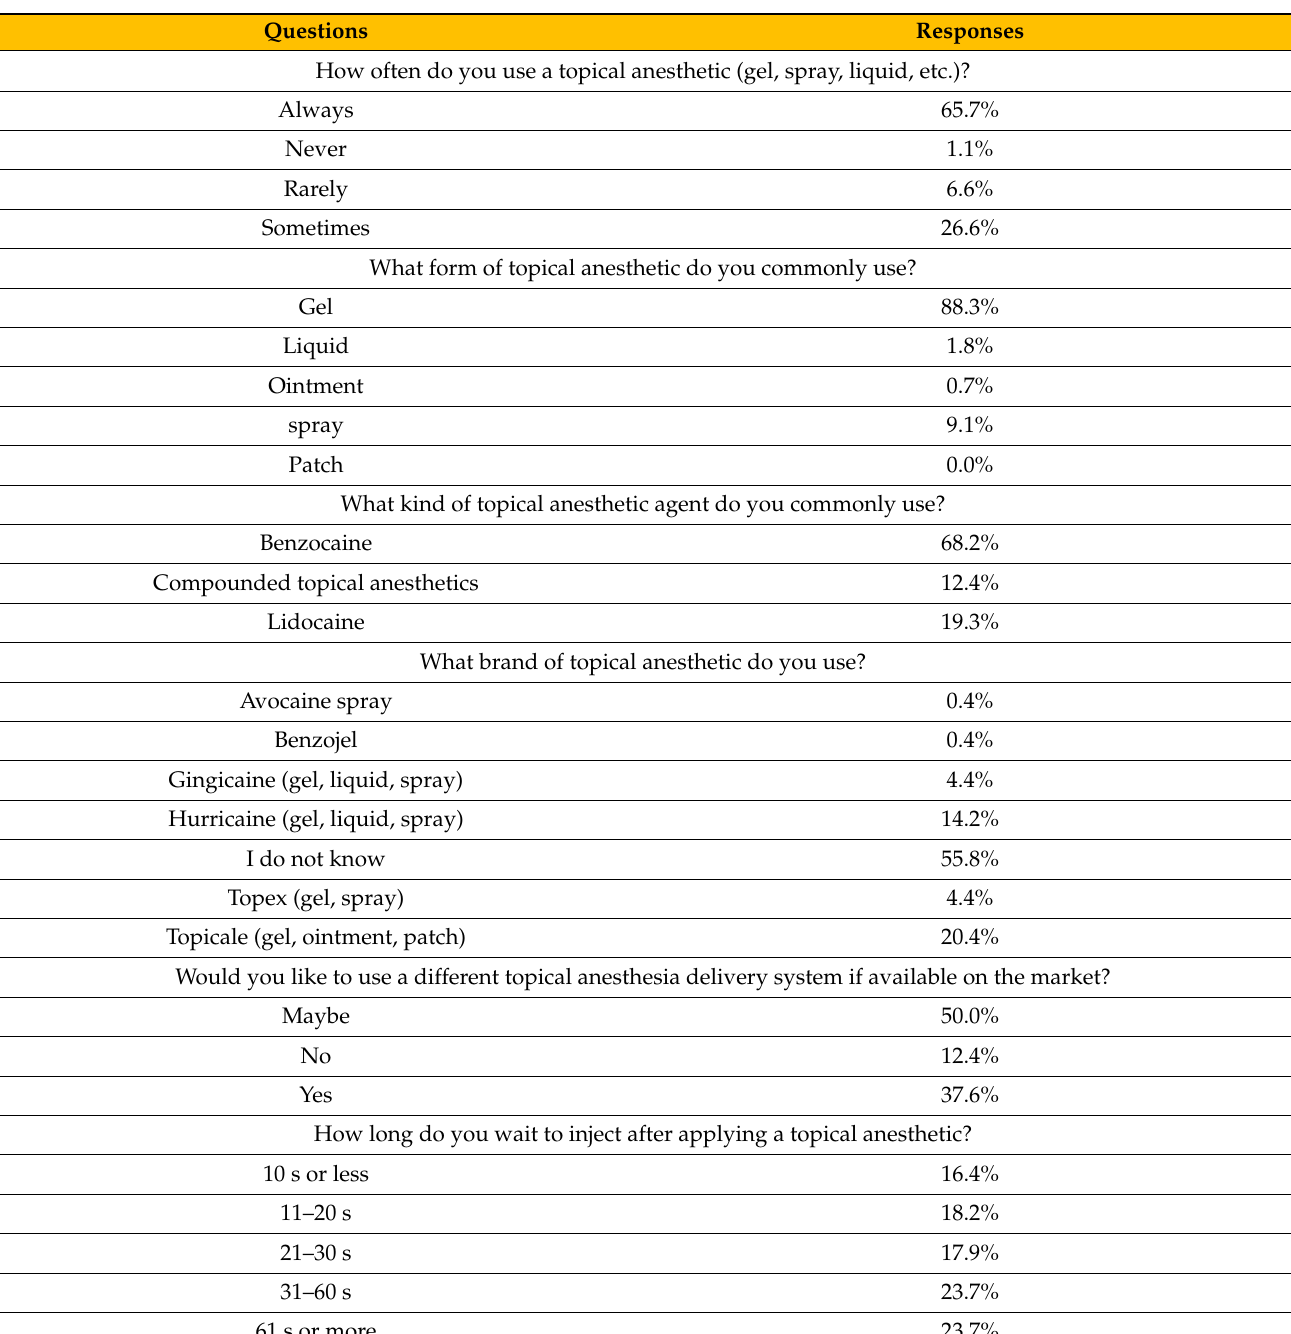
Table 4. Overall scores achieved by all participants regarding topical anesthetics used for